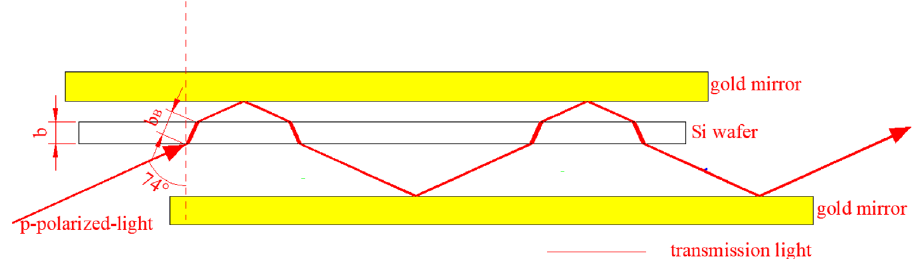
Figure 6. Light path chart of p-polarized light in the MTR